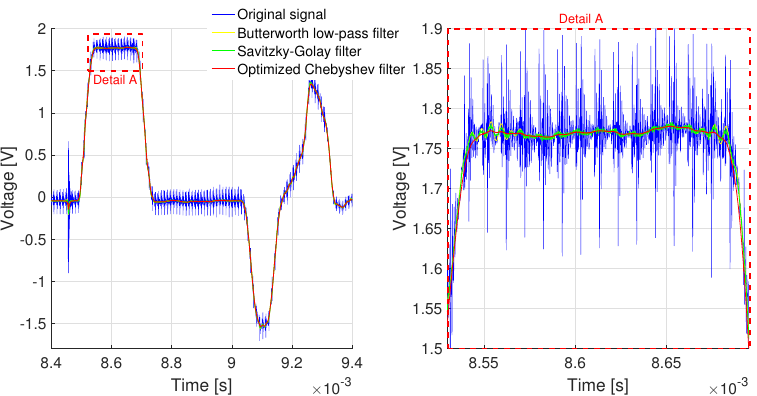
Figure 8. Comparison between different filters for incident signal: l striker velocity)